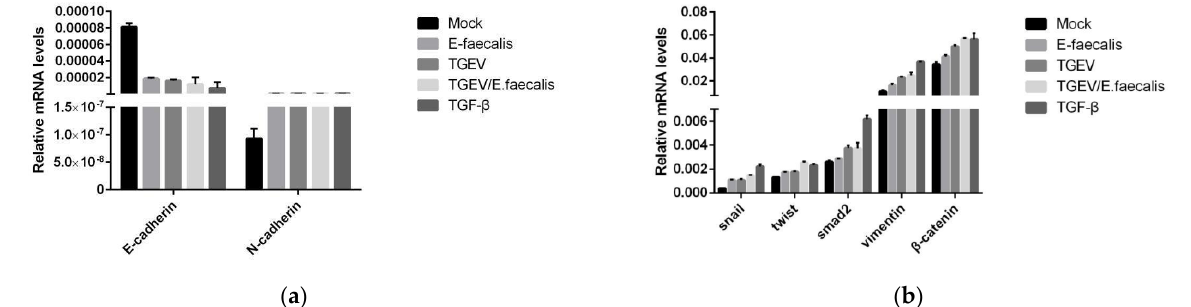
Figure A2. Evaluation of the effect of Enterococcus faecalis on the transcription level of EMT markers by RT − PCR. (a) Expression levels of E-cadherin and N-cadherin; (b) Expression levels of snail, twist, smad2, vimentin and β -catenin.